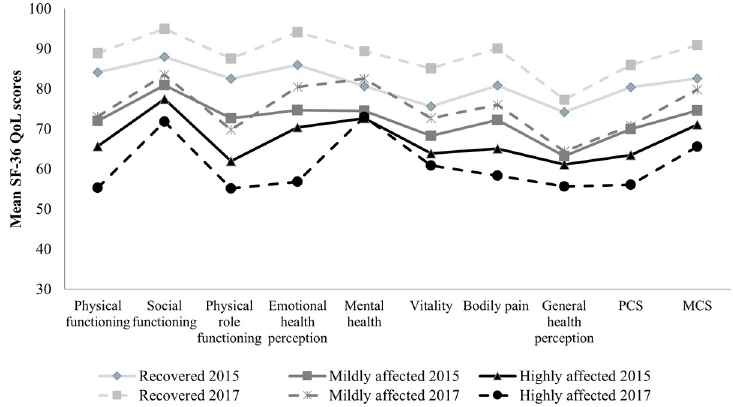
Fig 5. Mean 36-item short-form health survey quality of life (QoL) scores according to long-term chikungunya disease status (n = 248). The 2015 and 2017 QoL comparison of the recovered n = 107, mildly affected n = 87, and highly affected n = 54 groups, classified in